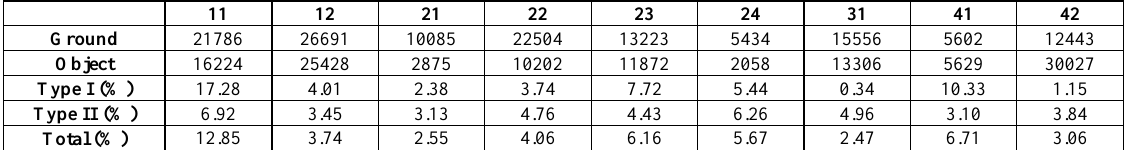
Table 2. Filtering result of sample 11-42